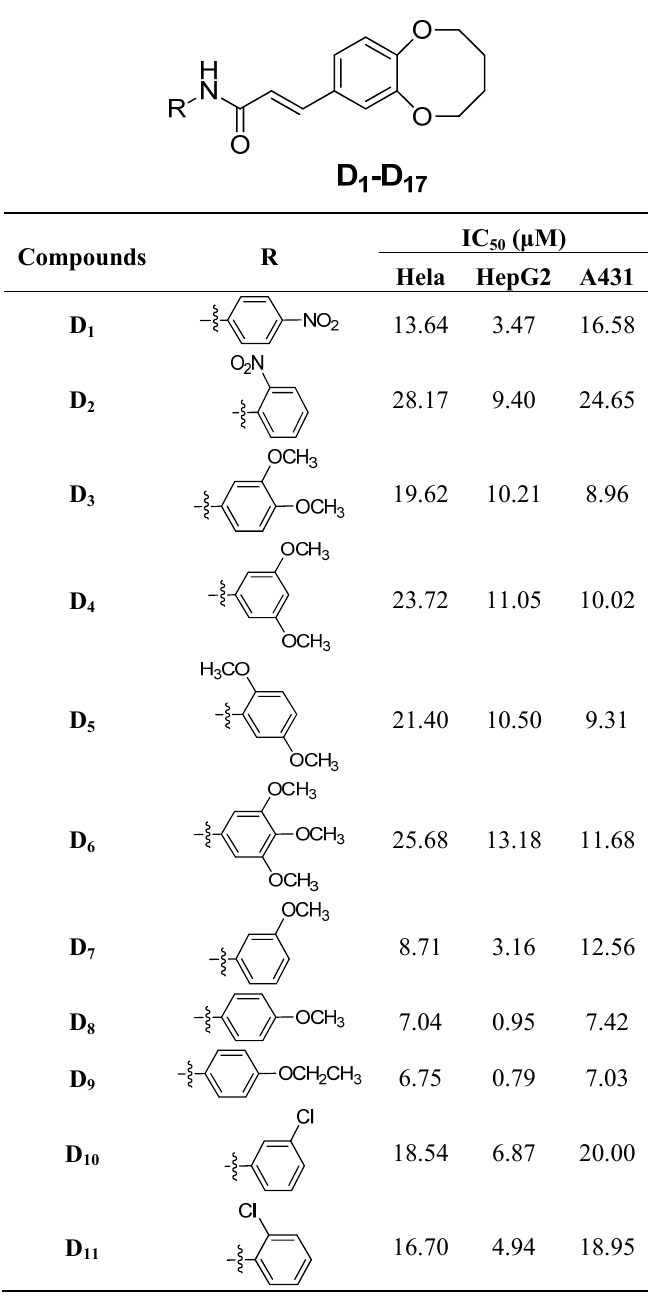
Table 2. Inhibition (IC ) of Hela, HepG2 and A431cells proliferation by compounds 50 D -D (After cells incubation with compounds for 24 1 17